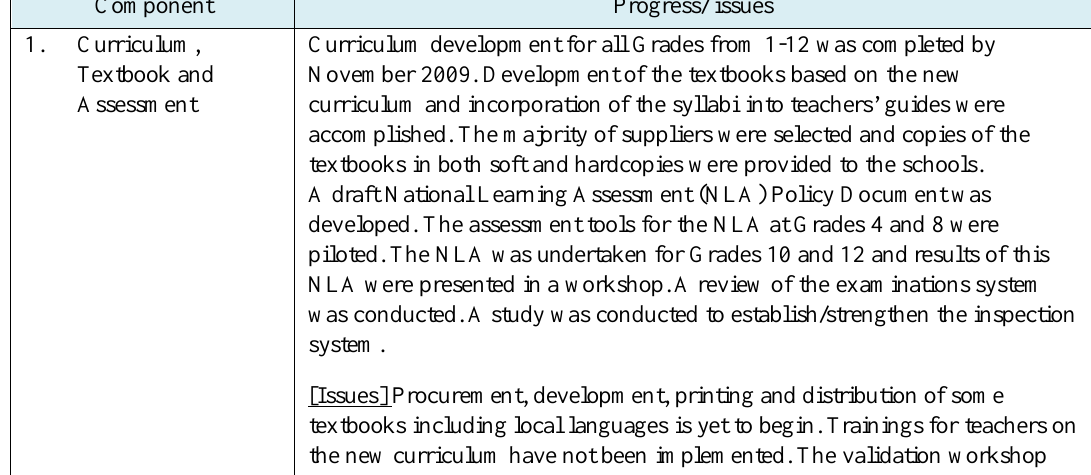
Table 6-1: GEQIP Components and Progresses